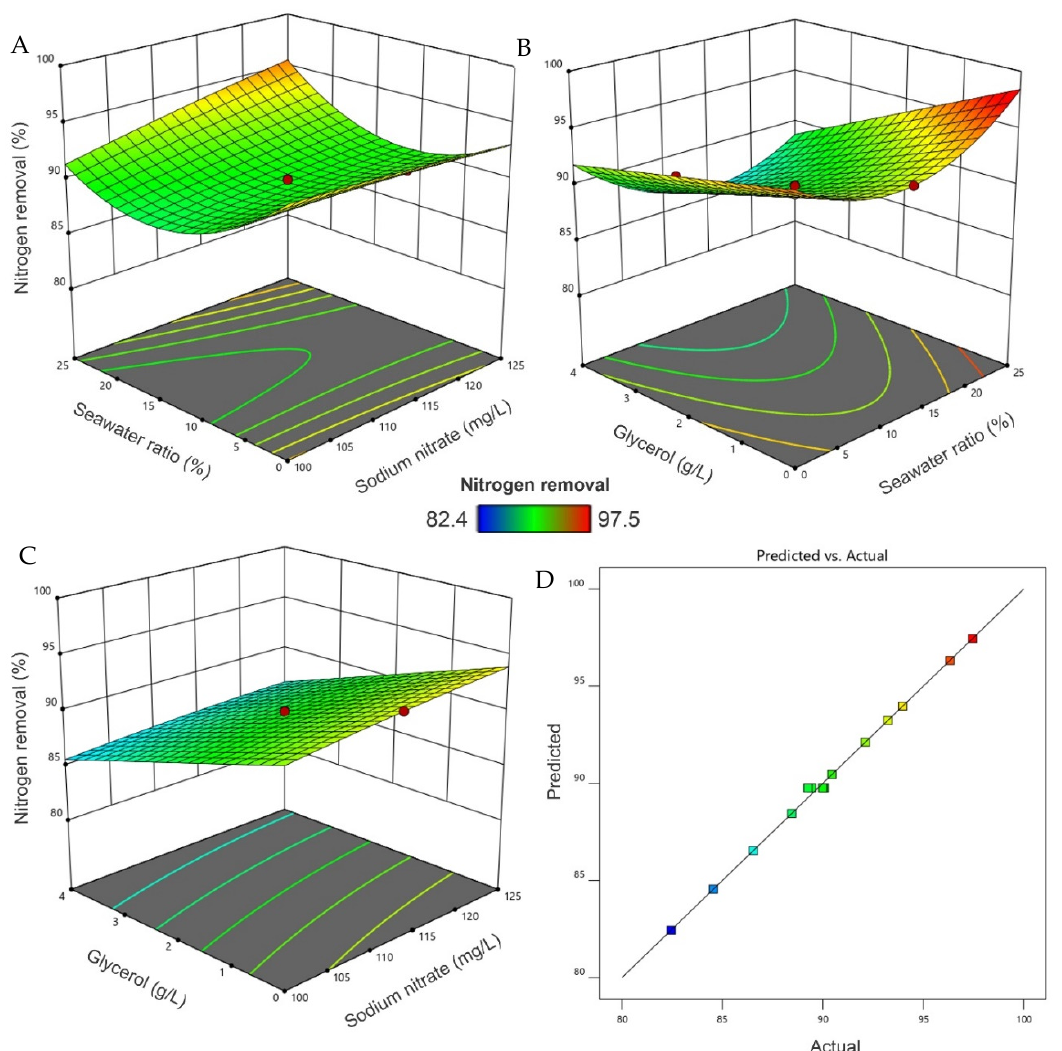
Figure 6. Central composite design showing the nitrogen removal responses to different studied conditions of sodium nitrate, seawater, and glycerol (A–C) with the fitting graph of actual and predicted values (D).